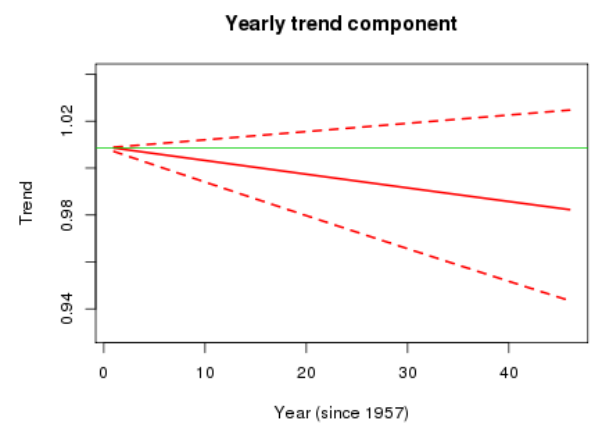
Fig. 11. Results from the model applied to an alternative area: spa- tial field and seasonal factor